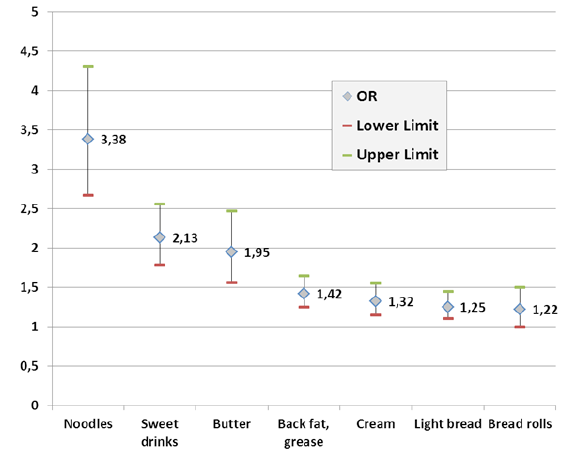
Figure 3. Estimated obesity risk and frequency of consumed food. Multivariable logistic